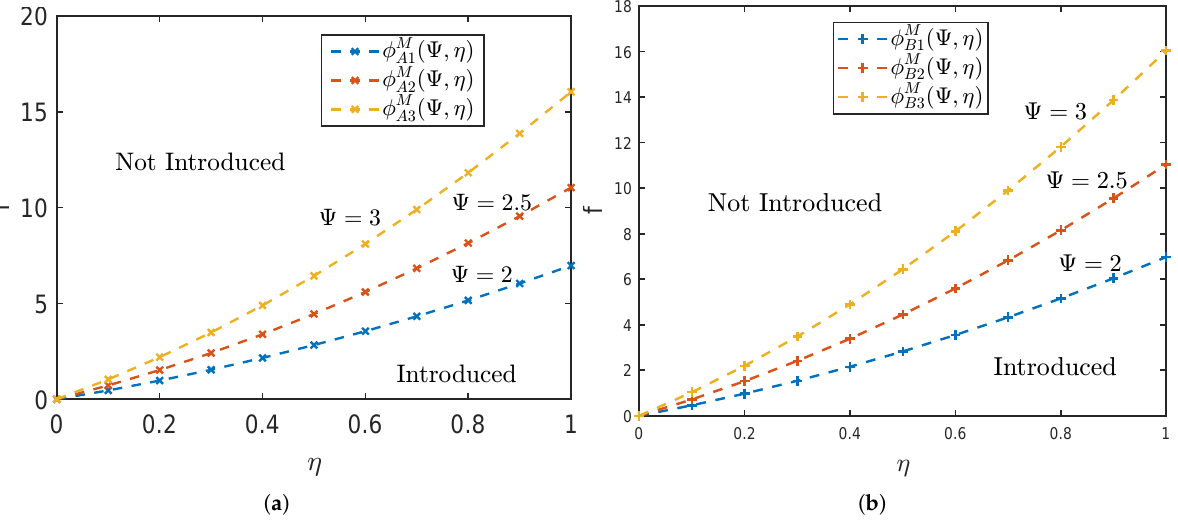
Figure 5. Optimal Strategy in Multi-homing Markets. ( a ) Platform A’s Optimal Strategy. ( b ) Platform B’s Optimal